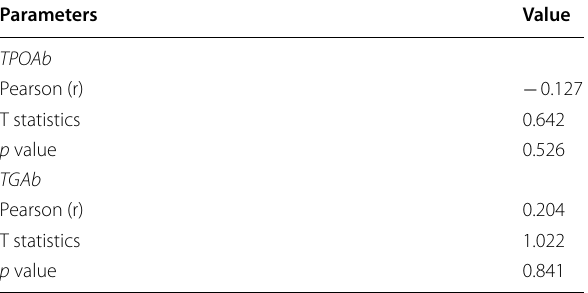
Table 3 Correlation of SWE with TPOAb and TGAb in AIT